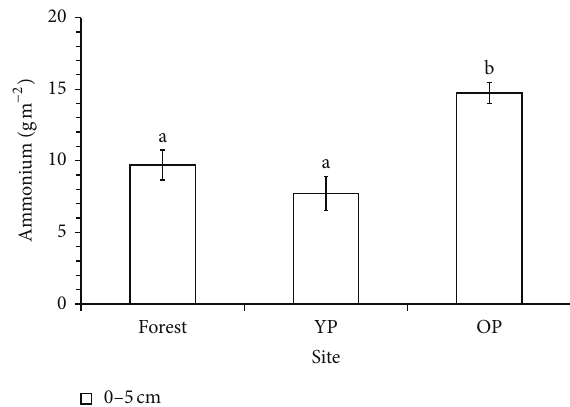
Figure 2: Mineralized ammonium accumulated during 15 weeks of the incubation experiment in laboratory conditions in forest and pasturessoils.Meanvalueswithstandarderrorbarsacrossforestand pastures. Different lowercase letters indicate significant differences between sites ( 𝑃 < 0.05 ). YP: 5-year-old pasture; OP: 18-year-old pasture.